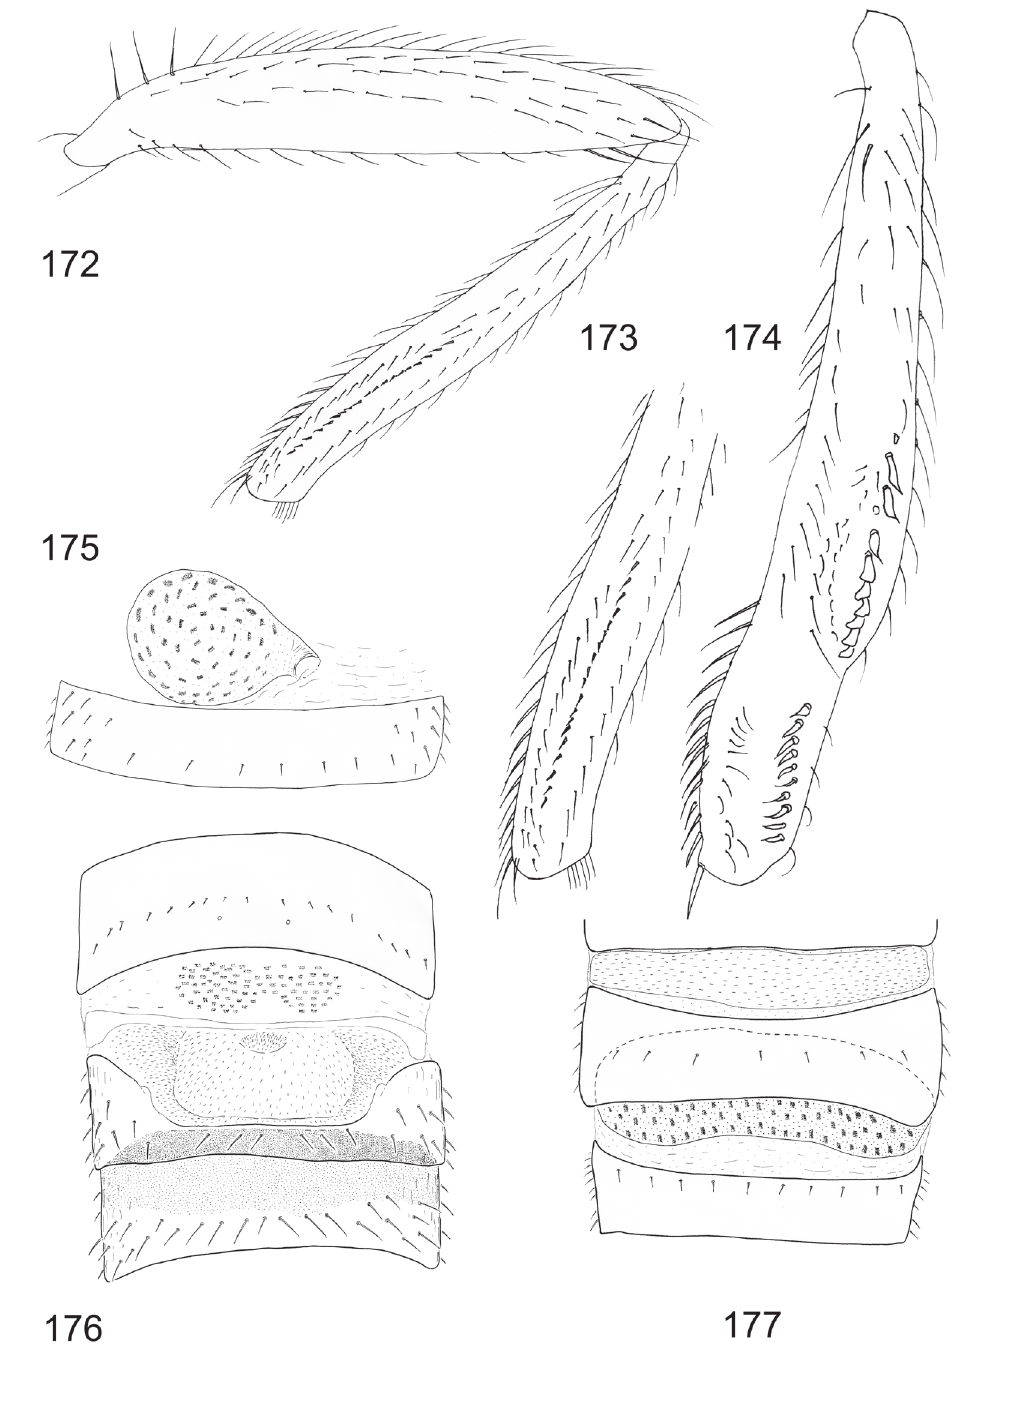
Figs 172-177. Nanodromia , ♂. 172 . N. hutan sp. nov., hind leg, anterior view. 173 . N. hutan sp. nov., tip of hind tibia, dorsal view. 174 . N. phukhao Grootaert & Shamshev, 2003, hind tibia, dorsal view. 175 . N. narmjeud Grootaert & Shamshev, 2003, bladder-like gland between tergite 4 and 5, dorsal view. 176 . N. narmkroi Grootaert & Shamshev, 2003, gland-like fields between tergites 4-5 and 5-6, dorsal view. 177 . N. phukhao Grootaert & Shamshev, 2003, gland-like fields between tergites 4-5 and 5-6, dorsal view. (Figs 174-177 after Grootaert & Shamshev